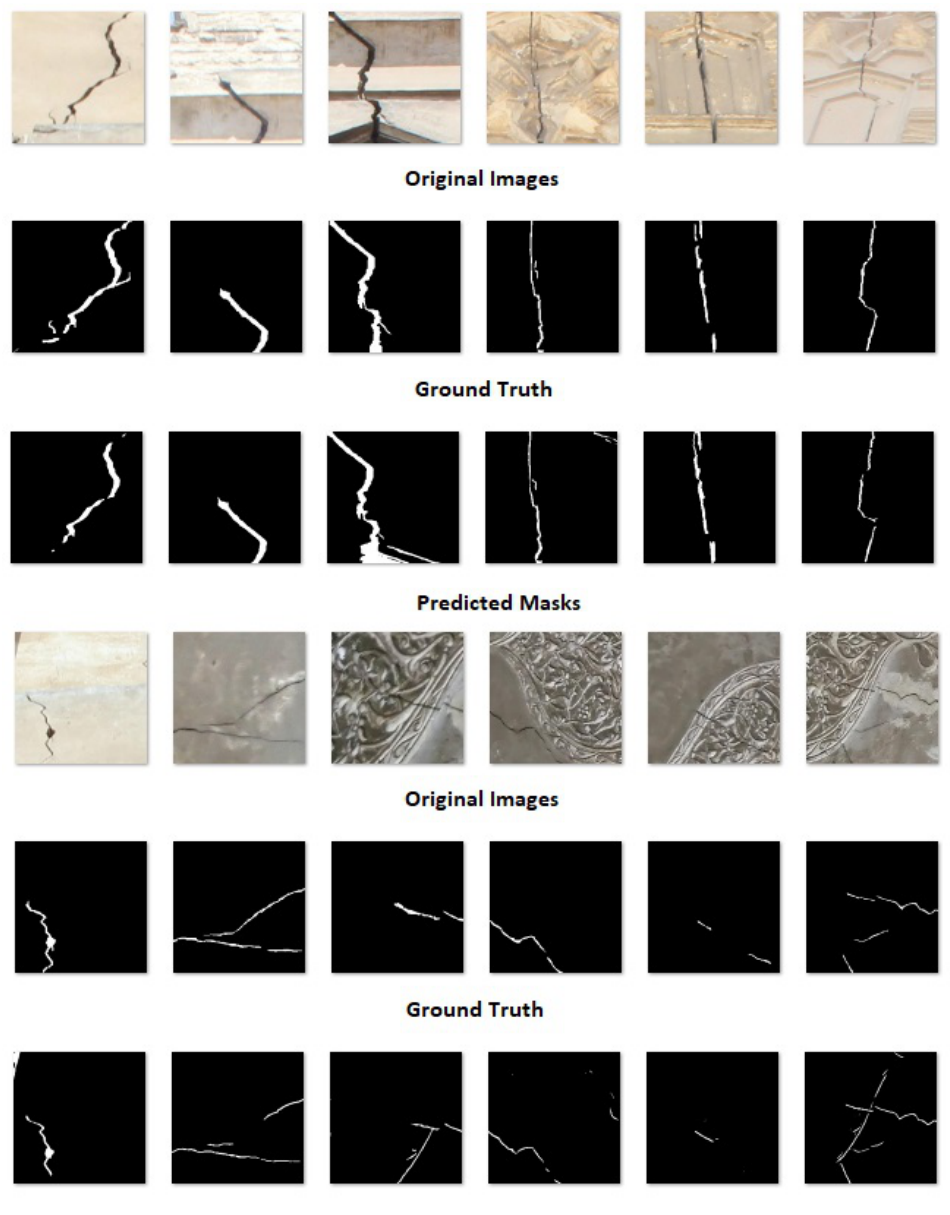
Figure 11. U 2 -Net result